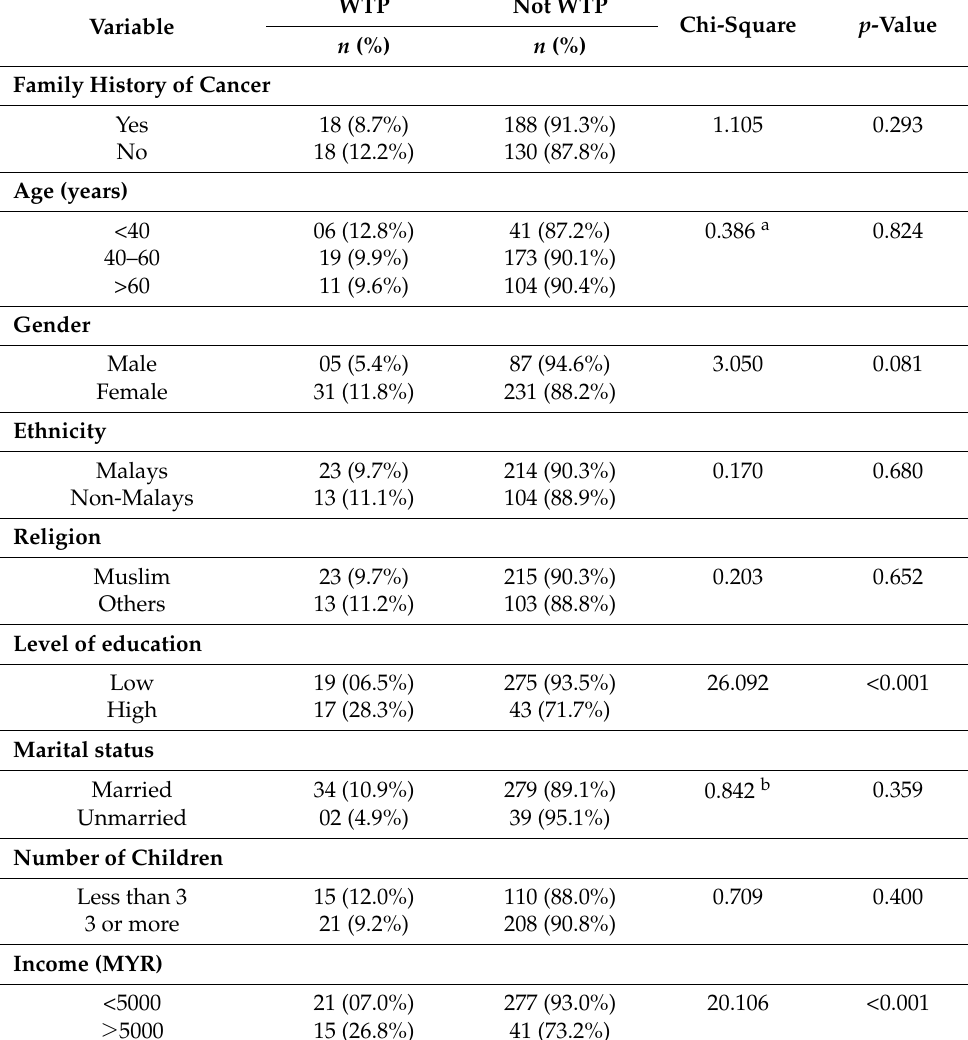
Table 3. Factors associated with WTP for cancer genetic testing among patients ( n =